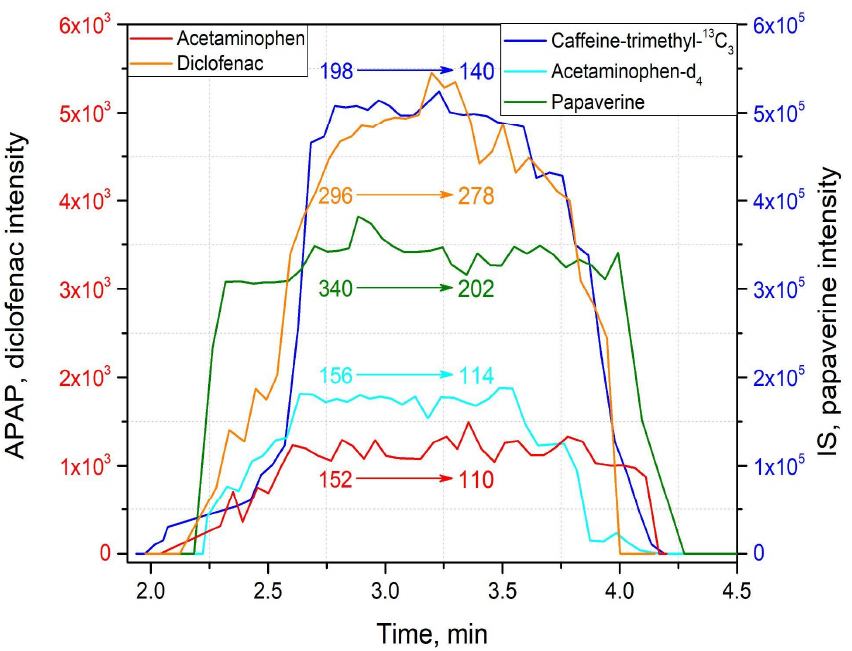
Figure 7. Extracted ion chronograms (EICs) obtained for acetaminophen (2500 ng/mL), diclofenac (2500 ng/mL), papaverine (2500 ng/mL) and internal standards caffeine-trimethyl- 13 C 3 (100 μ g/mL) and acetaminophen- d 4 (100 μ g/mL) in positive ion mode for determination of LOD.